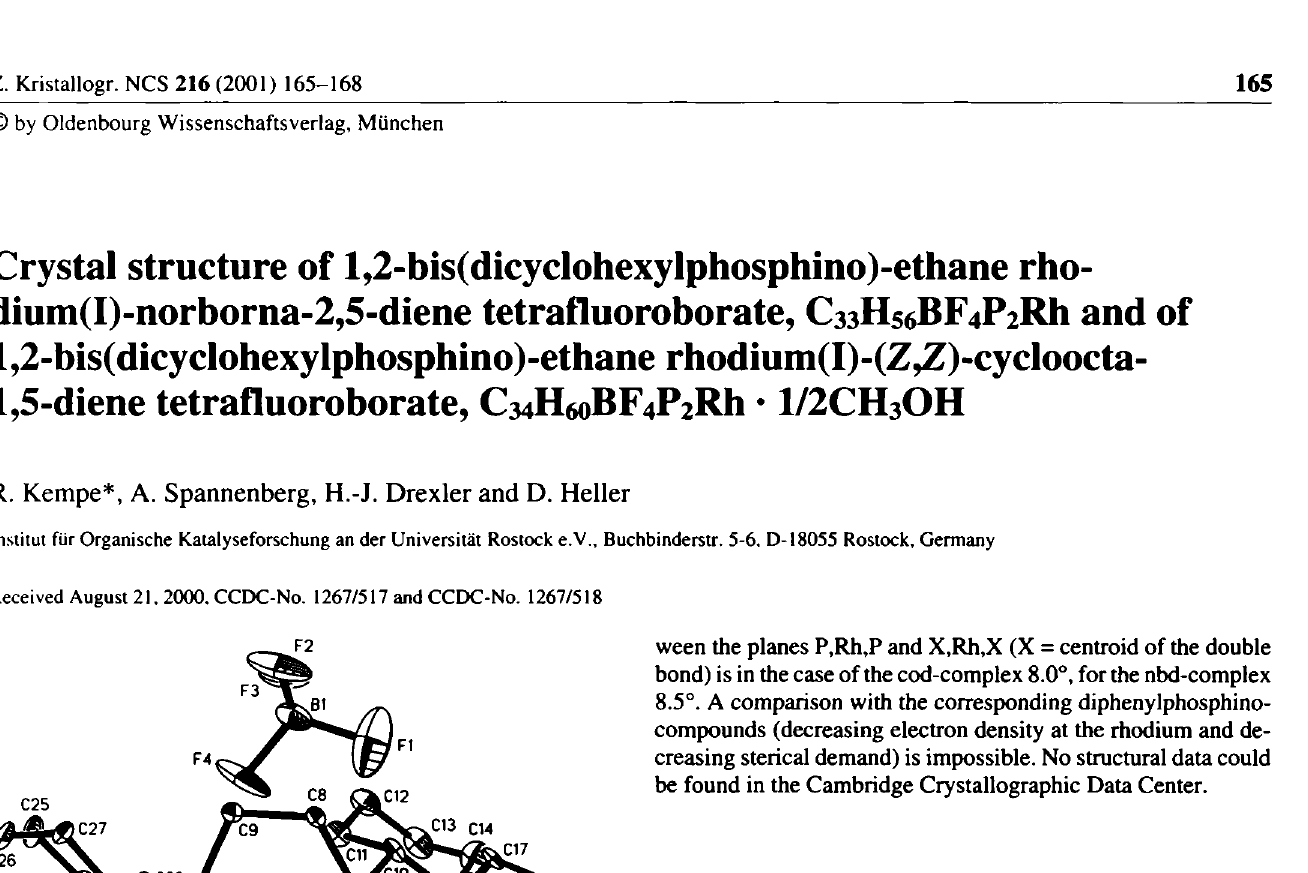
Table 1. Data collection and handling.